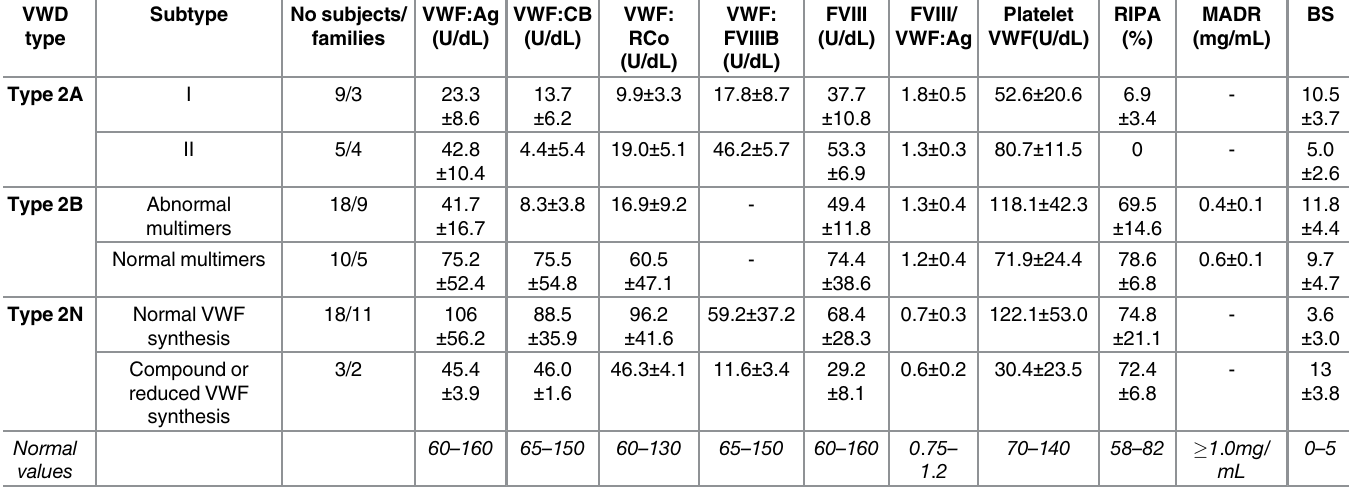
Table 3. Main haemostatic findings of the VWD patients studied characterized by VWF functional abnormalities.